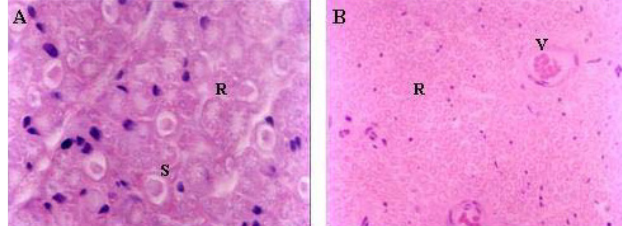
FIGURE 3 – Photomicrograph of the sciatic nerve of the rat in cross- section in the experimental group (original magnification 3A-100X, 3B-40X.). A: R – Nerve Regeneration / S – Schwann Cell. B: S – R – Nerve Regeneration / S – Schwann Cell./ V – Vessel.